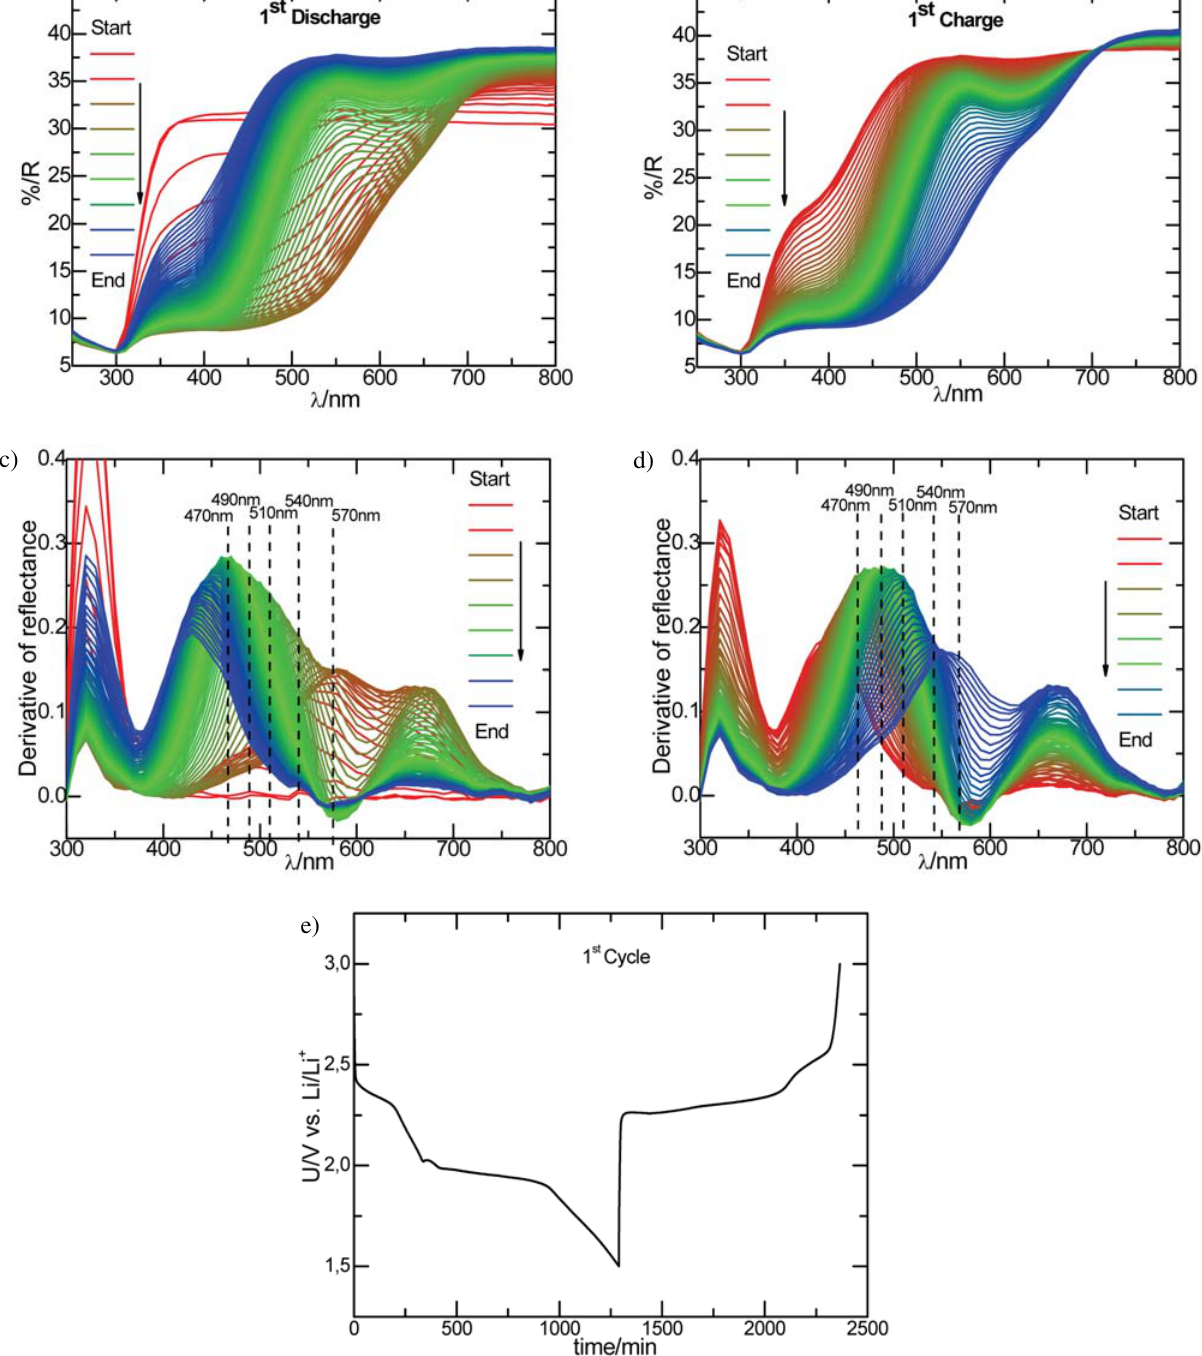
Figure 4. a, b) Obtained UV-Vis spectra from discharge and charge cycle of carbon/S composite. c, d) The first derivative of the obtained spectra during discharge and charge cycle showing shifts in the wavelength. e) The electrochemical curve of in-situ UV-VIS measurement of carbon/S